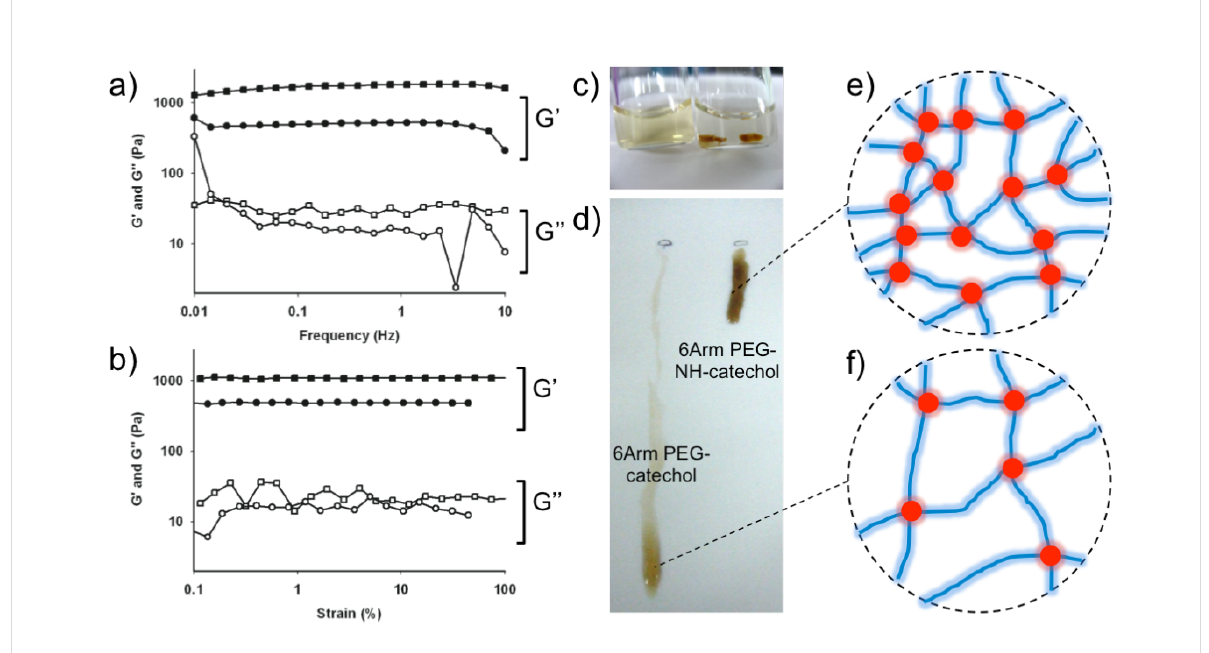
Figure 3: Rheological analysis data of quinone tanning inspired crosslinking hydrogels (a) frequency sweep and (b) strain sweep of 6Arm-PEG-NH- catechol (square) and 6Arm-PEG-catechol (circle). (n = 3 each) (c) Rapid quinone tanning of 6Arm-PEG-NH-catechol (right) in NaIO 4 (100 mM in DDW). A visible tanning reaction was not observed in 6Arm-PEG-catechol (left). (d) Measurement of gelation kinetics by dropping solutions of 6Arm- PEG-NH-catechol (right) and 6Arm-PEG-catechol (left) on a PTFE surface (45 deg slope). (e and f) Schematic results showing nano-scale junctions formed by (e) 6Arm-PEG-NH-catechol and (f)